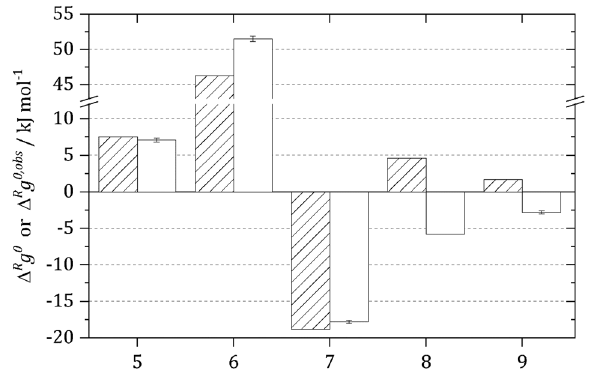
0, obs (striped 0 (white bars) of the glycolytic TPI